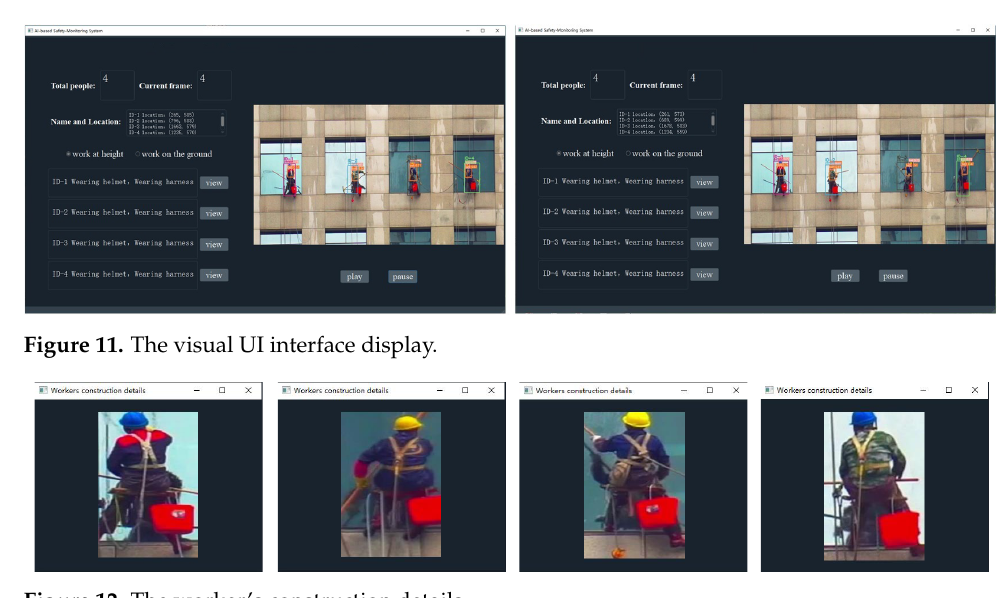
Figure 12. The worker’s construction